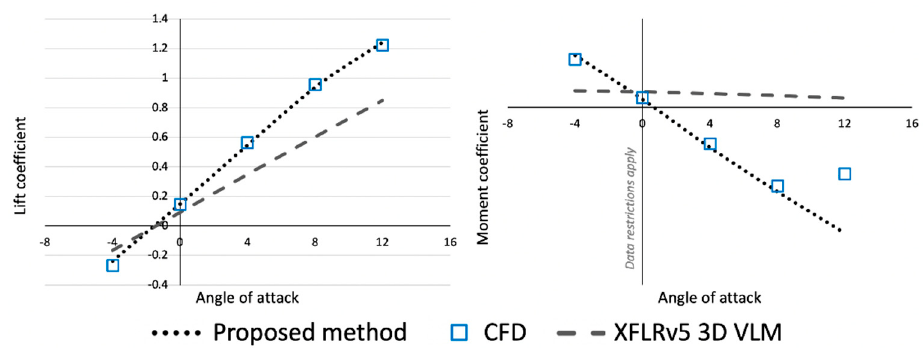
Figure 12. Lift ( left ) and pitching moment ( right ) coefficients versus angle of attack comparison between the examined methods (clean configuration). Table 3. Lift coefficient prediction comparison between the three methods.